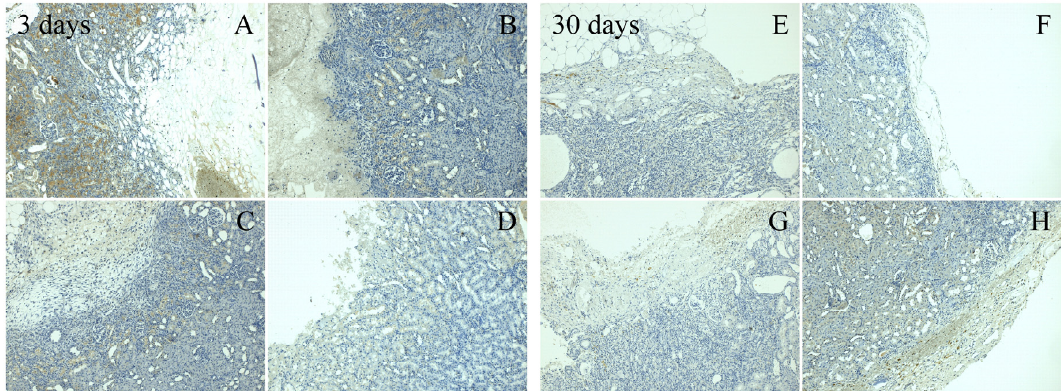
Figure 4. Immunohistochemical staining of TGF- β at 100× magnification. After 3 days (left section); ( A ) ORC, ( B ) HA/OX, ( C ) HA/CMC, ( D ) HA/CMC/ET: a very significant expression (+++) of the cytokine in all of the textiles A–D. After 30 days (right section); ( E ) ORC, ( F ) HA/OX, ( G ) HA/CMC, ( H ) HA/CMC/ET: medium expression (++) at E, only light expression (+) at F-H.